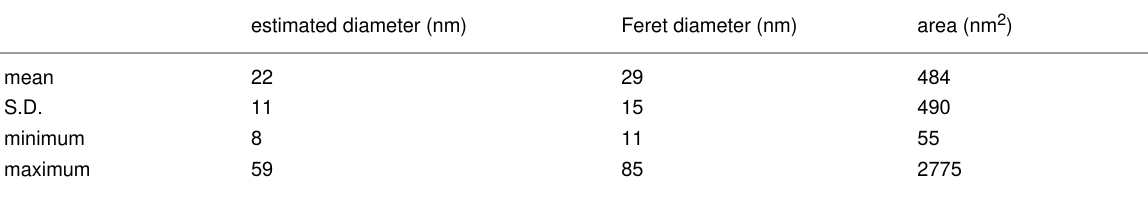
Table 1: NM-212 diameter and area determined from TEM